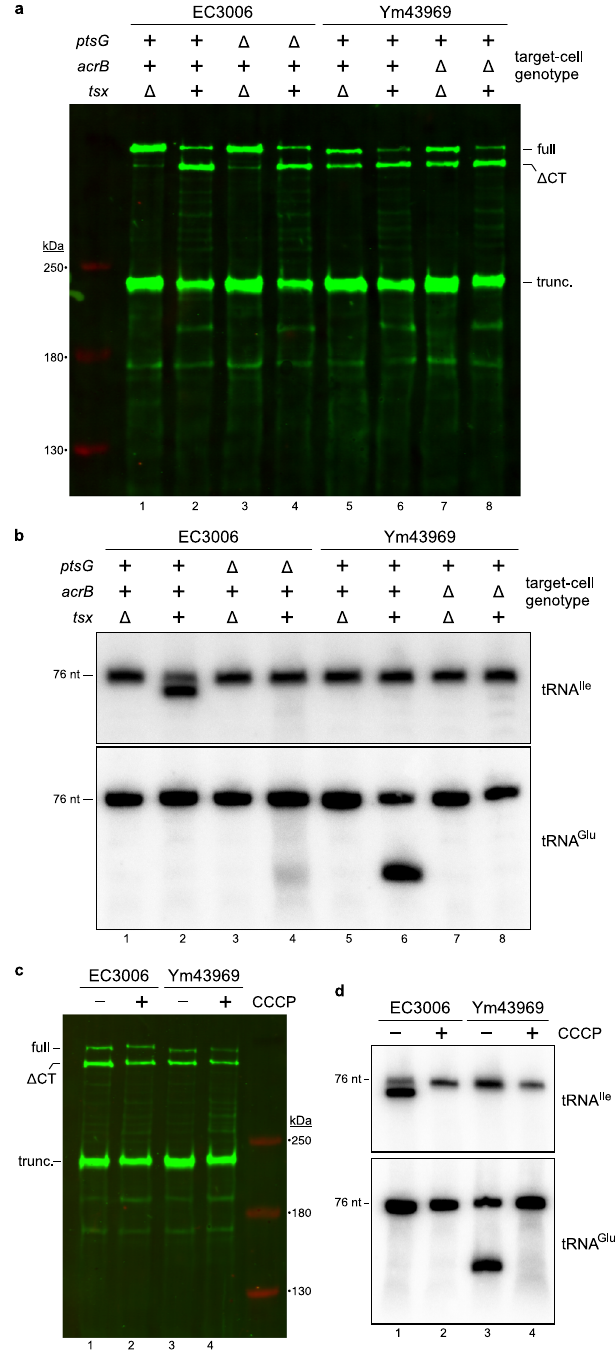
lanes2and4).Thus,CdiA-CTscanbedeliveredintotheperiplasmofde- energized target cells, but the proton motive force (pmf) is required for subsequent translocation into the target-cell cytoplasm.